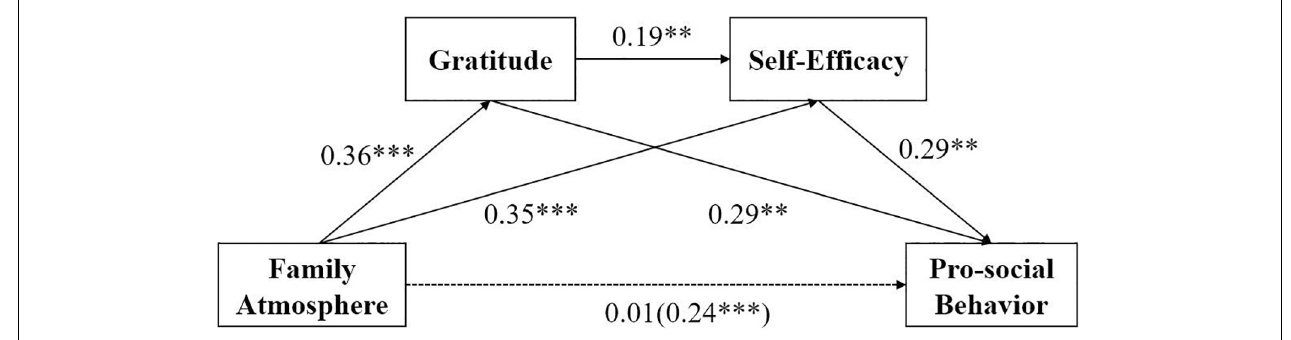
FIGURE 2 | The mediating effects model after controlling for grade, gender and